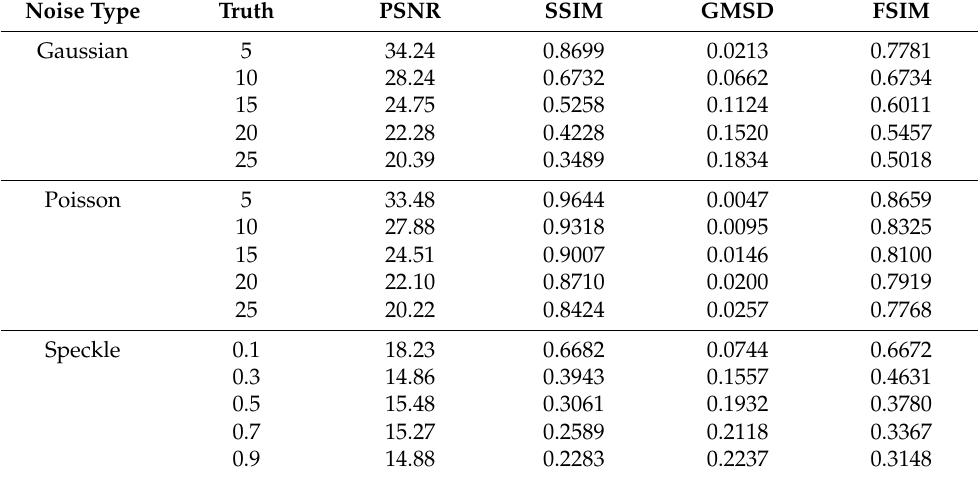
Table 1. Image quality assessment of different noise